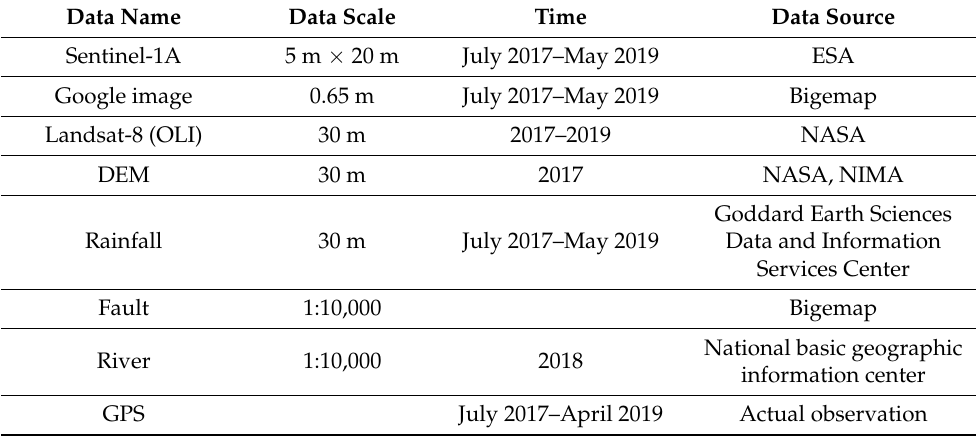
Table 1. Experimental data parameters.